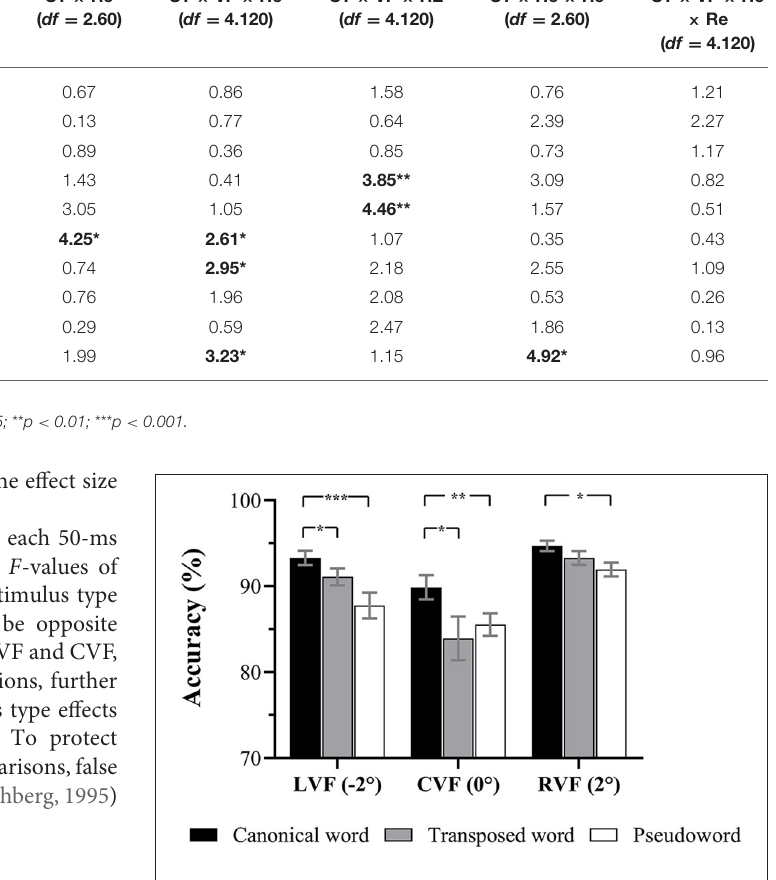
FIGURE 2 | Mean accuracy of identifying T1 and T2 in the correct order. Error bars represent standard errors (SEs). * p < 0.05; ** p < 0.01; *** p <